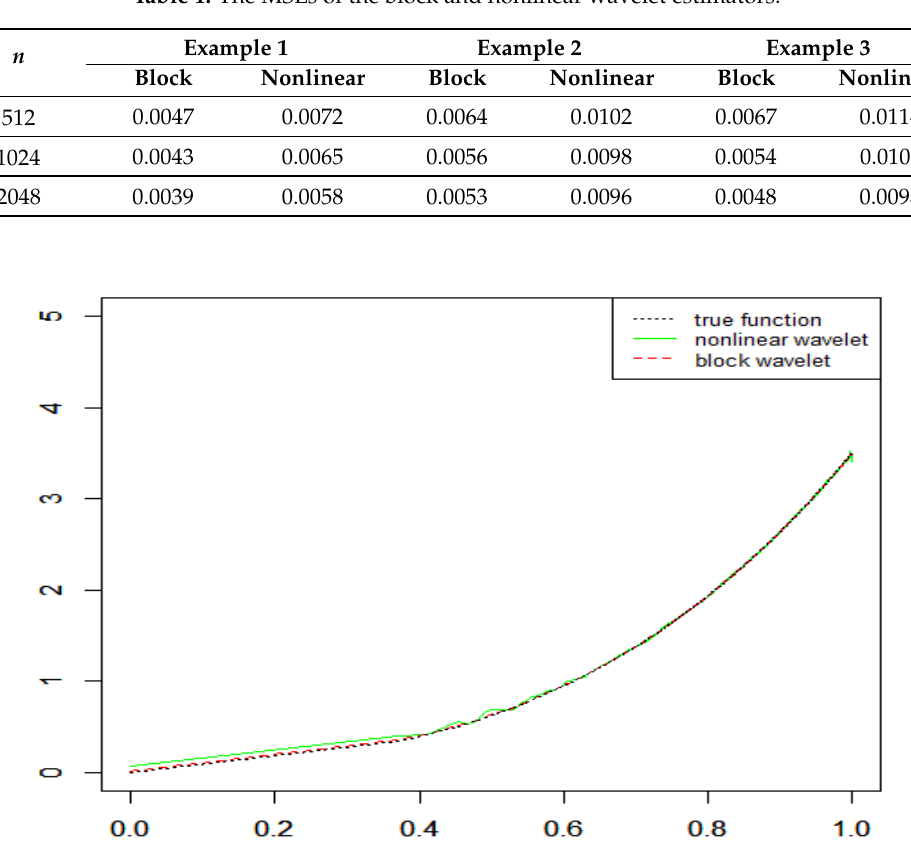
Figure 1. Recovery of the density function for NA samples in Example 1 ( n =